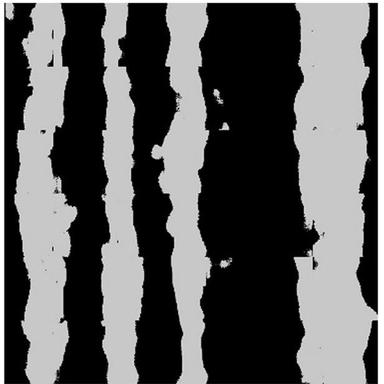
Re-joint image with recognized results using U-Net model.